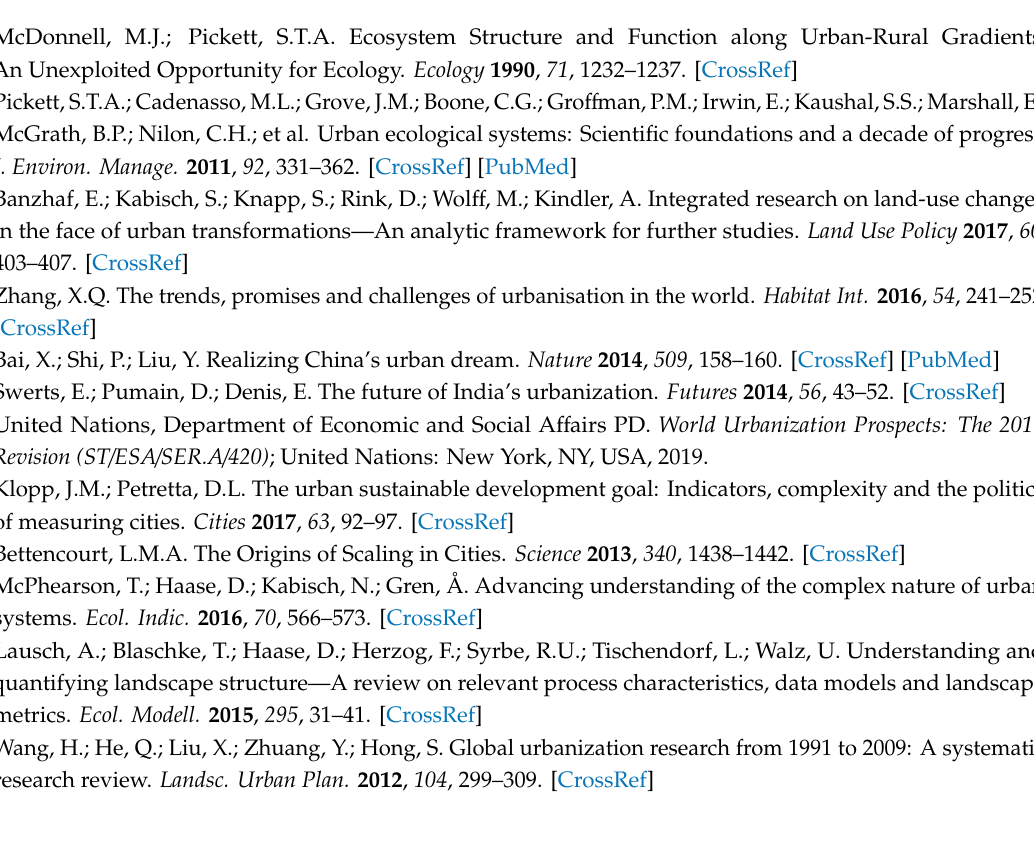
Figure S1: Landscape metrics (LPI, LSI, AWMPFD and AI) change at 2000 m cell size- year 1999, 2009 and 2017, Figure S2: Landscape metrics (LPI, LSI, AWMPFD and AI) change at 1000 m cell size- year 1999, 2009 and 2017, Figure S3: Spatial clusters of landscape metrics at 2000 m cell-size in 1999, 2009 and 2017 identified through LISA along with their Global Moran’s I value, Figure S4: Spatial clusters of landscape metrics at 1000 m cell-size in 1999, 2009 and 2017 identified through LISA along with their Global Moran’s I value, Table S1: Administrative wards of Srinagar city, Table S2: Details of satellite data used, Table S3: Characterisation of LULC classes, Table S4: Number of reference sites associated with each class generated by probability proportional to size (PPS) sampling